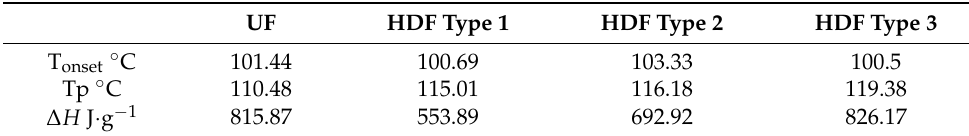
Figure 10. DSC heat of reaction thermograms of adhesive systems (black: UF, red: HDF Type 1, blue: HDF Type 2, green: HDF Type 3). Table 4. DSC results of adhesive systems used in this work.